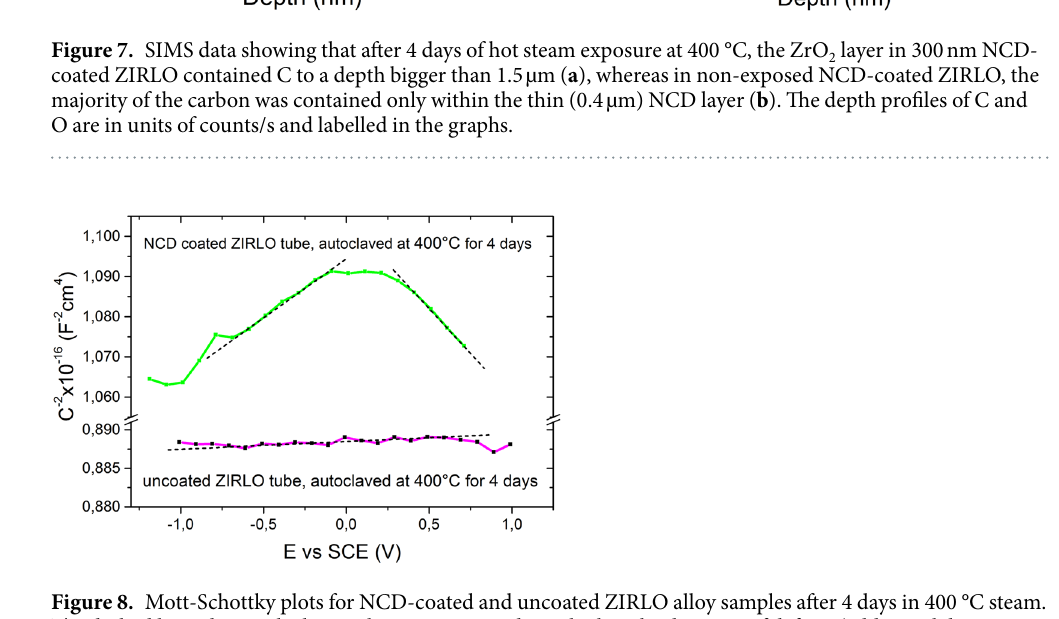
Figure 8. Mott-Schottky plots for NCD-coated and uncoated ZIRLO alloy samples after 4 days in 400 °C steam. The dashed lines denote the linear slope regions used to calculate the densities of defects (additional donors/ acceptors). Both the zirconium oxide and the NCD layer clearly exhibited semiconductive behavior.